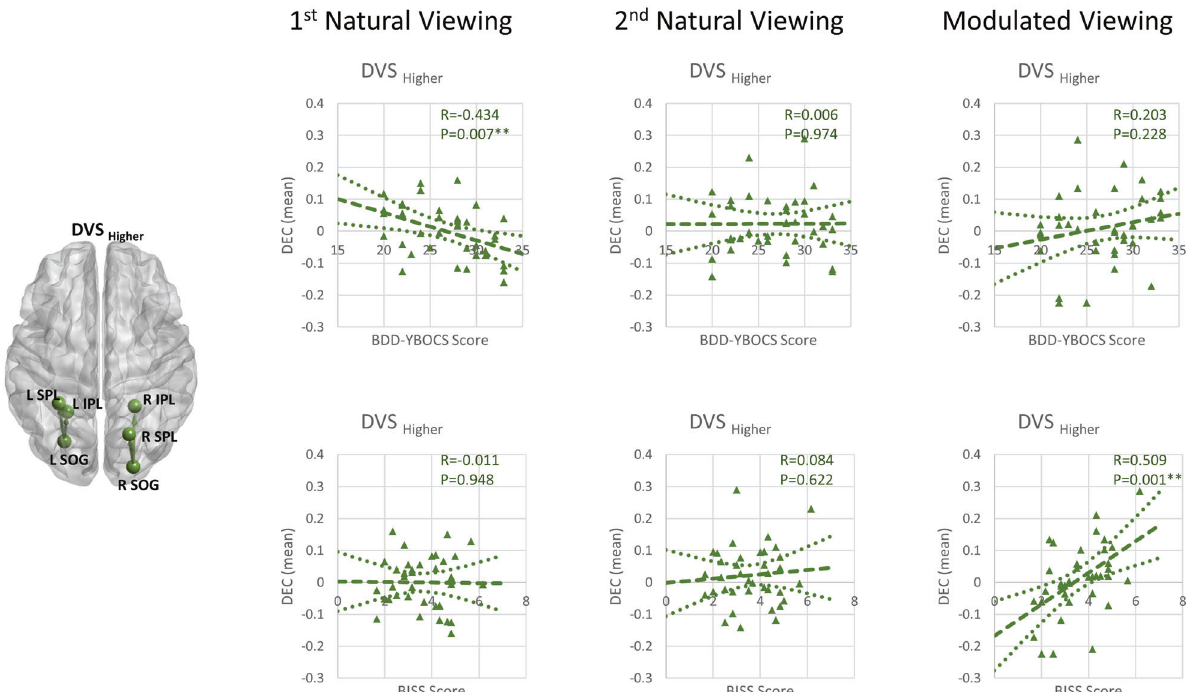
Fig. 4 Brain Connectivity and Clinical Symptom Associations. Correlations between mean dynamic effective connectivity (DEC) from occipital to parietal regions in the dorsal visual stream and clinical measures across BDD participants during the fi rst naturalistic viewing, the second naturalistic viewing, and the modulated